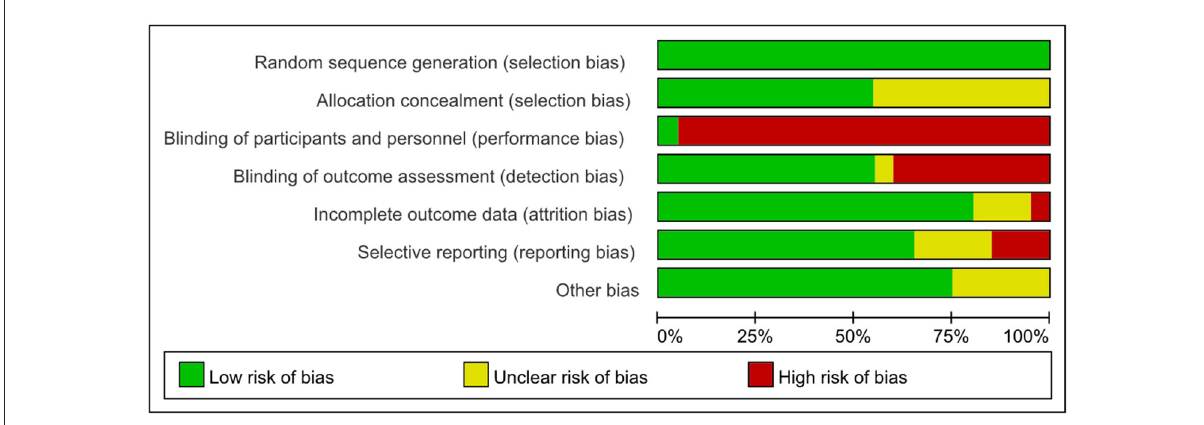
FIGURE3 Risk of bias summaries for all exercise